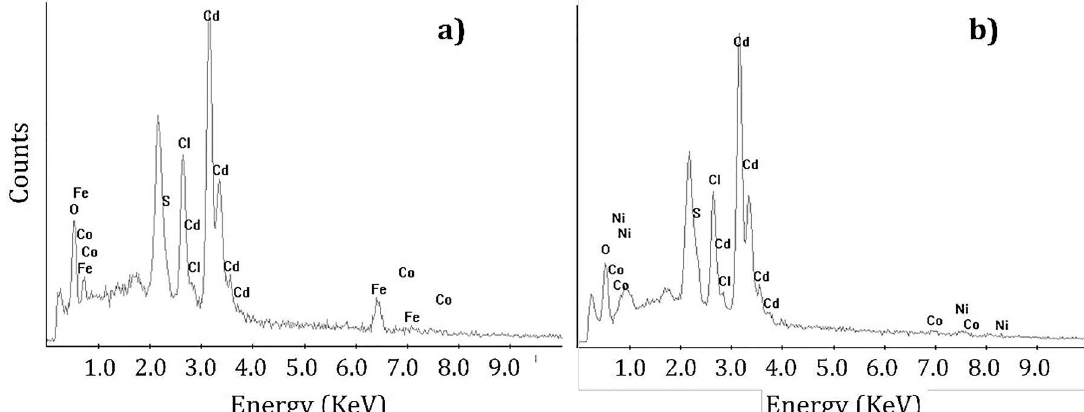
Figure 1. EDS spectra of: a) CdS from the first extraction process; b) CdS produced from reaction between the obtained from the second extraction.